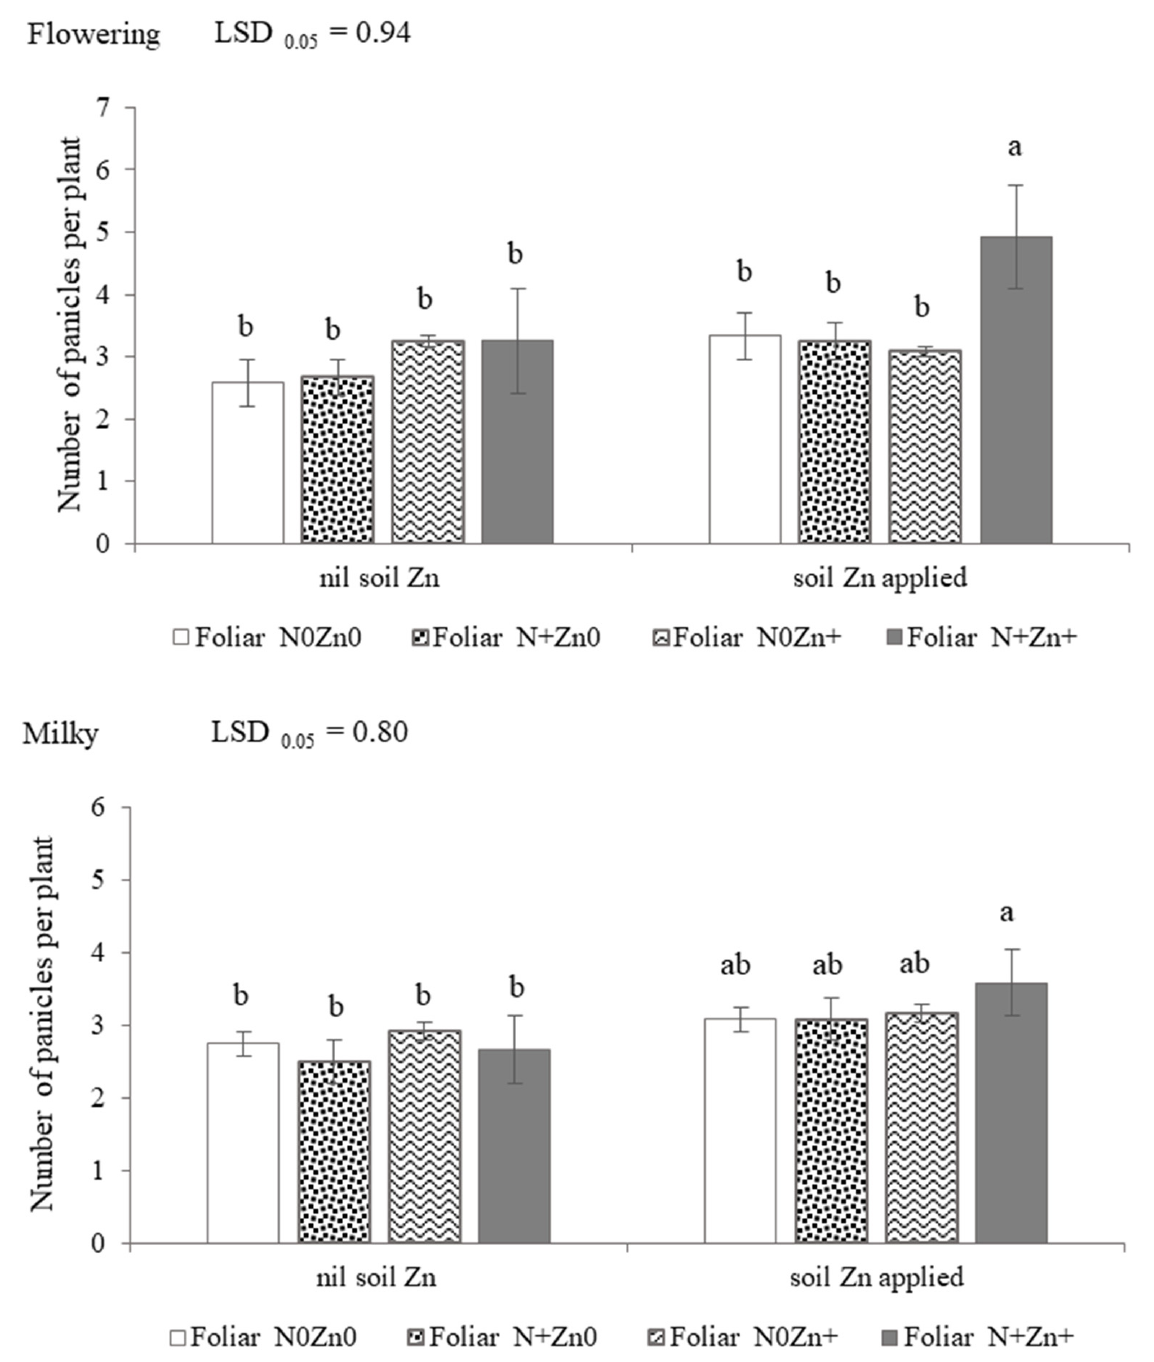
Figure 4. Number of panicles per plant of the SPT1 rice variety grown at different foliar N and Zn fertilizer rates under two soil Zn treatments at the flowering and milky stages. Each value is the mean of four independent replications. Different letters above the bars indicate significant differences by LSD (0.05). The error bars indicate the standard deviation of each treatment mean (SD) ( n = 4). Foliar application of N and Zn fertilizers at flowering and milky stages affected Zn and N concentrations in brown rice differently when the plants were grown under nil and added soil Zn ( p < 0.05) (Table 1). With nil foliar application (N0Zn0) at the flowering stage, grain Zn concentrations in brown rice were 7.2 and 10.8 mg Zn kg − 1 when plants were grown under nil soil Zn and added soil Zn, respectively, while at the milky stage, application of grain Zn yielded concentrations of 14.0 and 26.1 mg Zn kg − 1 ,